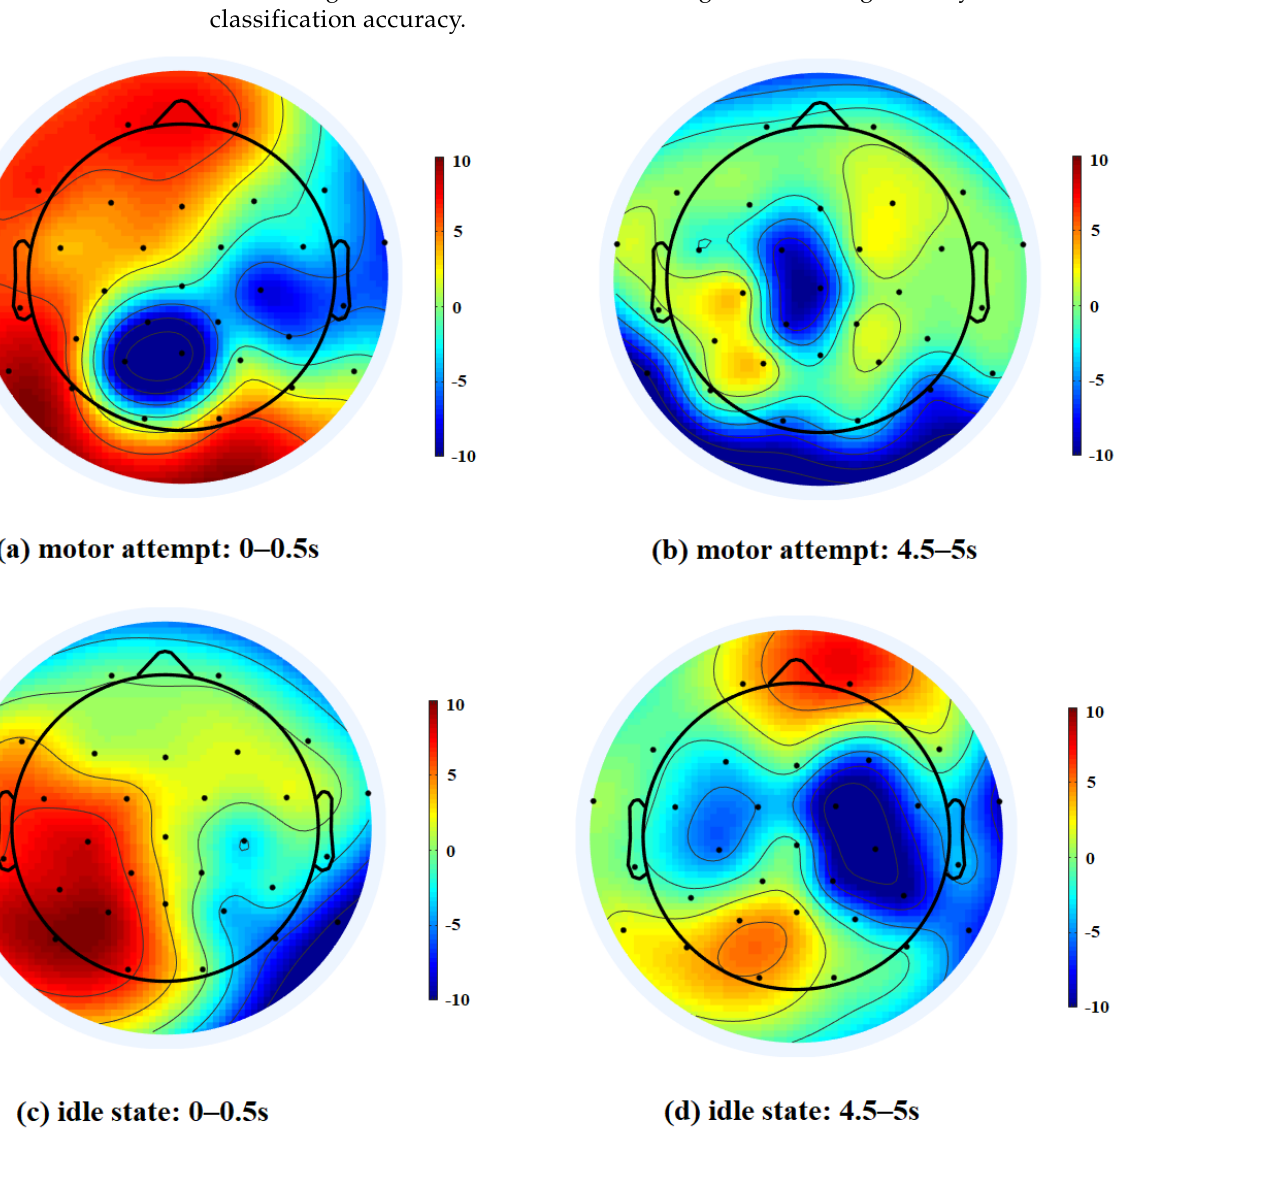
Figure 10. The visualization of the averaged topography of the PSD over the alpha band in different time windows. Session 3 with two task types for Subject 3 is